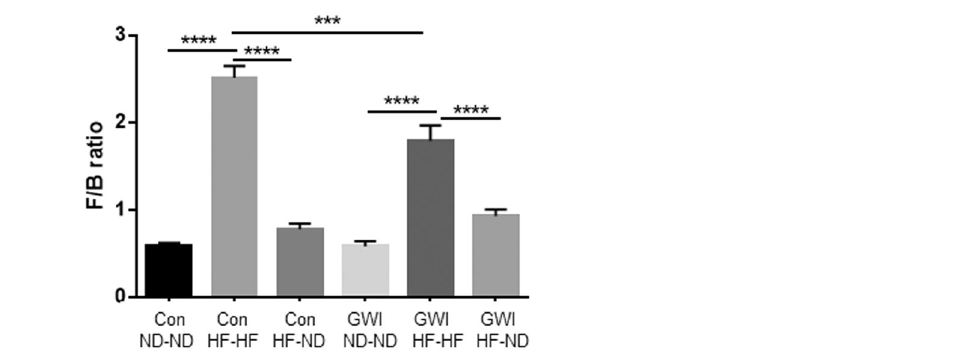
Figure 8. Firmicutes to Bacteroidetes (F/B) ratio in treatment and diet groups. Results are presented as means + SEM for each treatment and diet. Symbols represent significance levels for the indicated post hoc comparisons as p < : *** 0.001, **** 0.0001. Con = control; GWI = PER + PB; ND = normal diet; HF = high fat